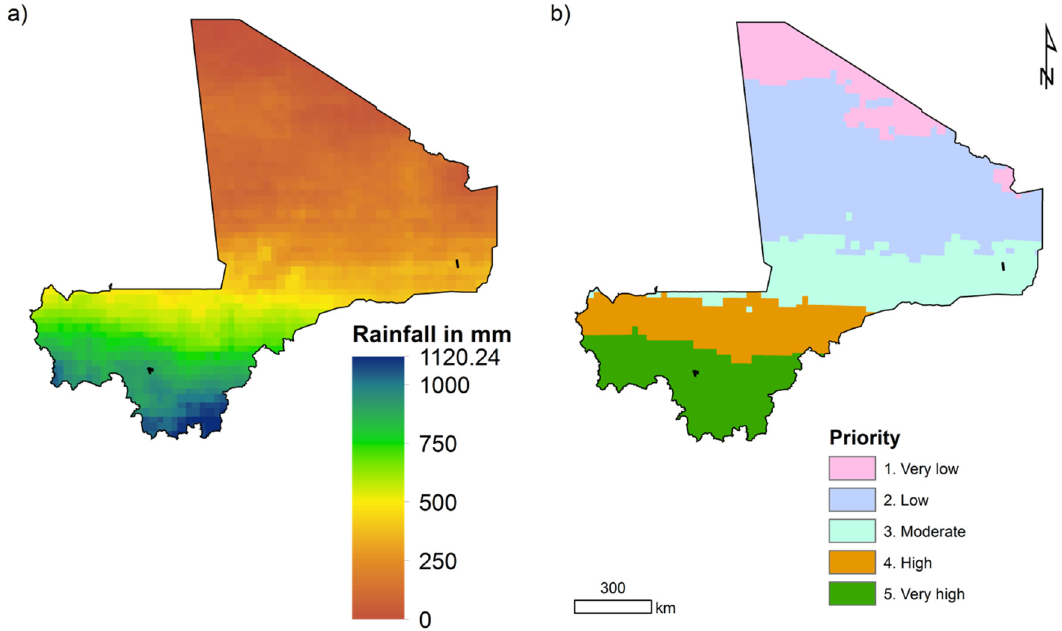
Figure 8. Mean Annual rainfall in Mali (taken from www.iwmidsp.org): ( a ) normal annual rainfall;